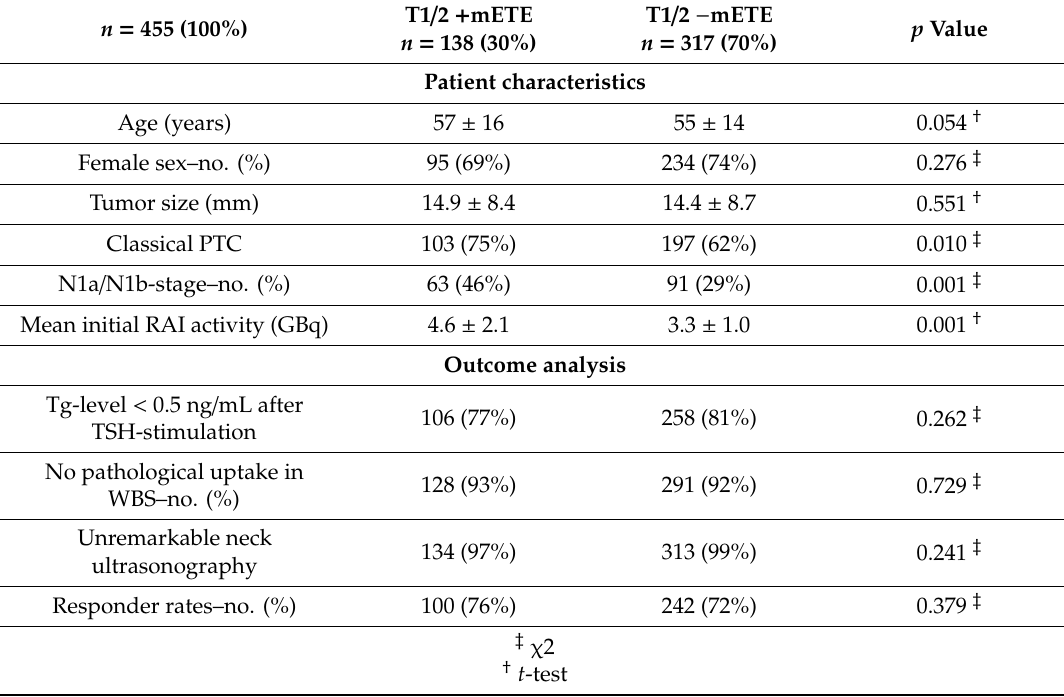
Table 1. Patient characteristics and outcome analysis of the entire